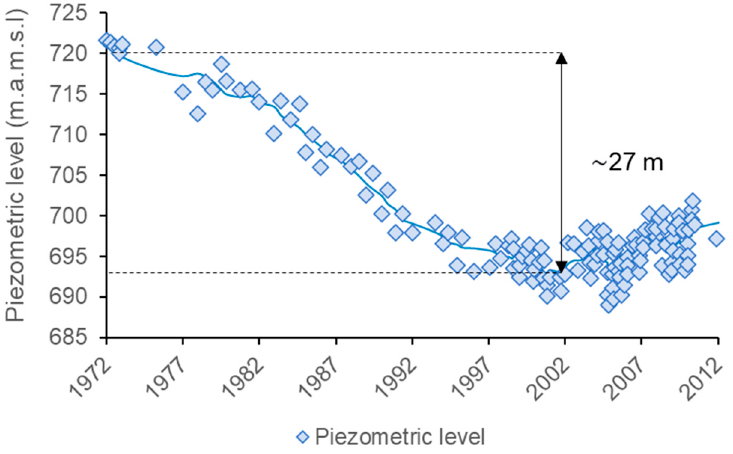
Figure 2. Measured and average piezometric levels at Mojados groundwater monitoring site (num- ber 3 in Figure 1) and approximate groundwater level drop between 1972 and 2002.